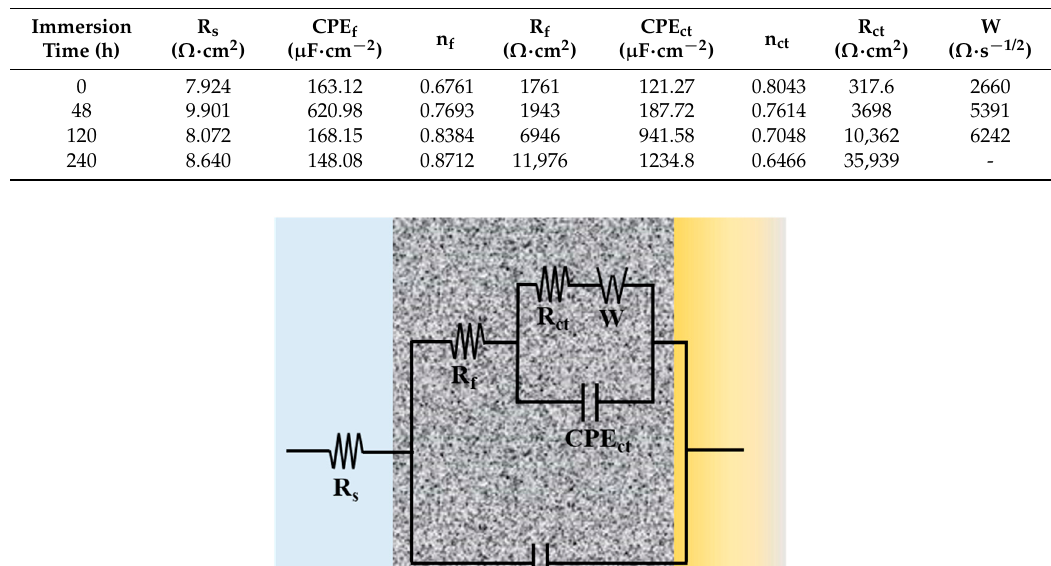
Table 3. Electrochemical equivalent circuit parameters by fitting analysis of specimens after different immersion times in 3.5 wt % NaCl solution.